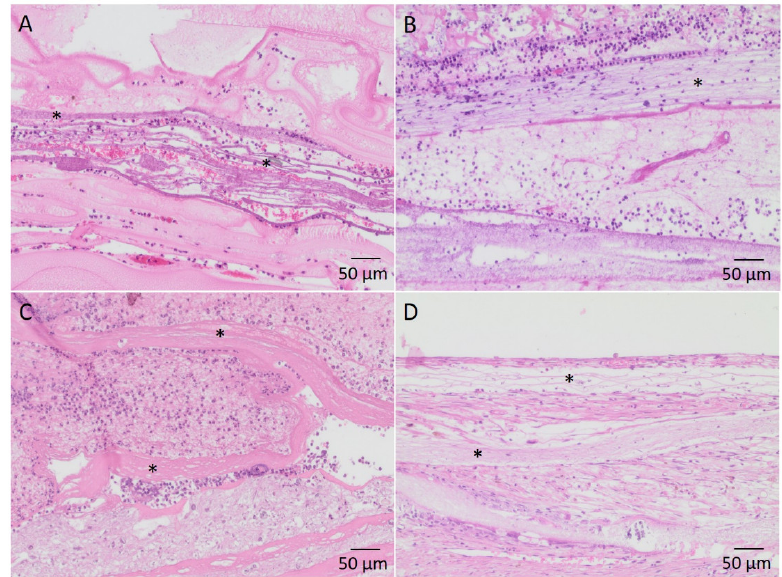
Figure 8. H&E stained sections showing infiltration of cells into the nanofiber scaffold layers. Ex- emplary nanofibers are marked by (*) ( A ): PCL-collagen I-PEO-scaffolds after two weeks of implan- tation; ( B ): PCL-collagen I-PEO-scaffolds after four weeks of implantation; ( C ): PCL-collagen I-scaf- folds after two weeks of implantation; ( D ): PCL-collagen I-scaffolds after four weeks of